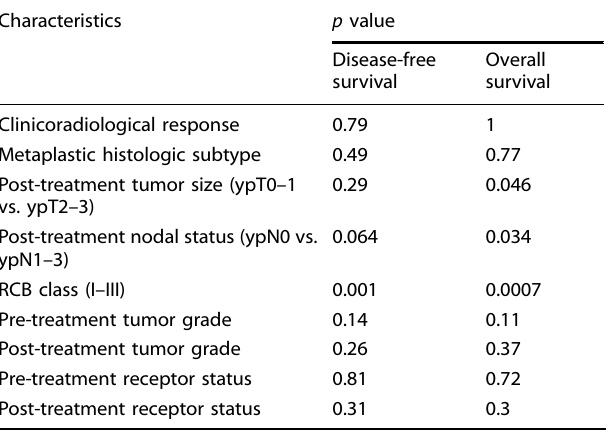
Fig. 2 Representative micrograph of the pre-neoadjuvant treatment core biopsy of the sole patient who had pathologic complete response. Note that the core biopsy revealed a matrix-producing metaplastic carcinoma, poorly differentiated. Magni fi cation ×200. Table 4. Clinicopathologic factors associated with disease-free survival and overall